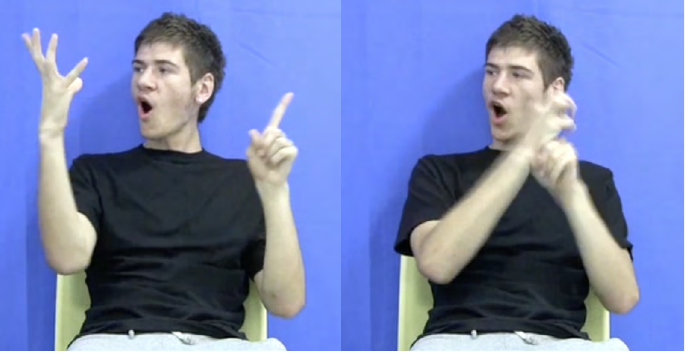
Figure 12. BSL grab using motivated space along side-to-side axis In another example, the indicating verb give moves from one location on the signer’s right to a lower location on the right to indicate that something was passed on from an adult to a child. The fact that the original location was set up during a sequence of constructed action where the signer recalled talking to someone at a football match further reinforces that the use of space in this instance is motivated. The other